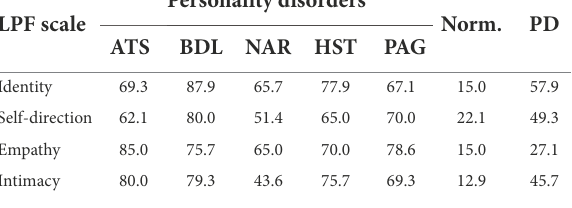
TABLE 3 Probabilities (%) of level of personality functioning (LPF) scales for cluster-B personality disorders. Personality disorders LPF scale